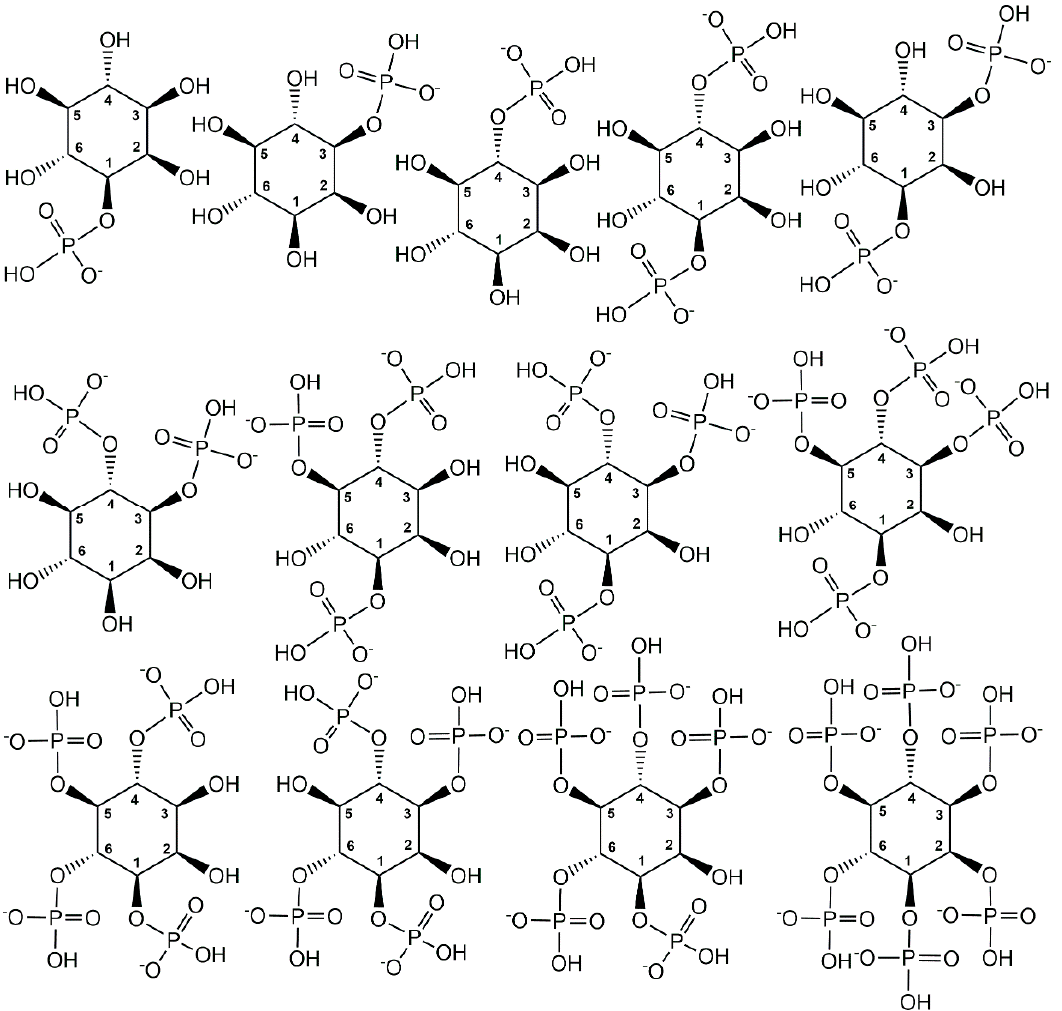
Figure 6. Structures of biologically active mono-, bis- tris-, tetra-, penta- and hexa-phosphorylated myo -inositols. Different myo -inositol phosphometabolites and their stereoisomers can be recognized by the carbon atom numbering of their phosphorylation sites.